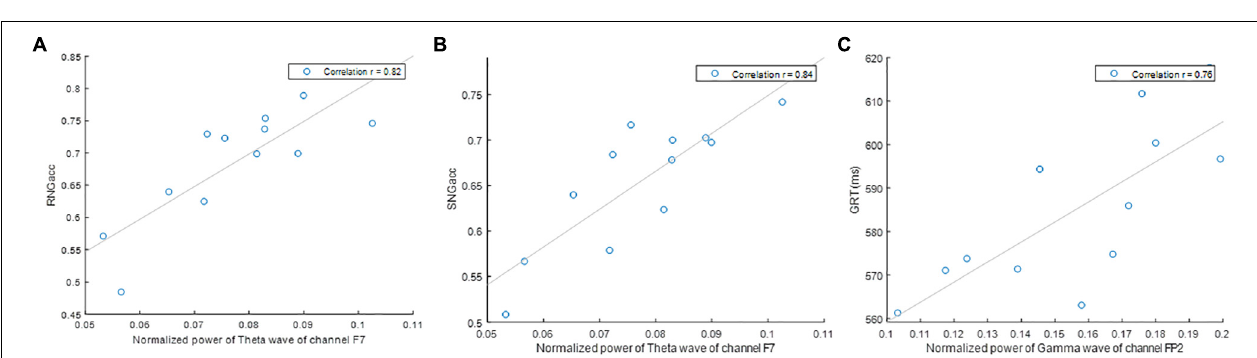
FIGURE 5 | Correlation of (A) RNGacc and power of theta wave of channel F7, (B) SNGacc and power of theta wave of channel F7, and (C) GRT and power of gamma wave of channel T8.